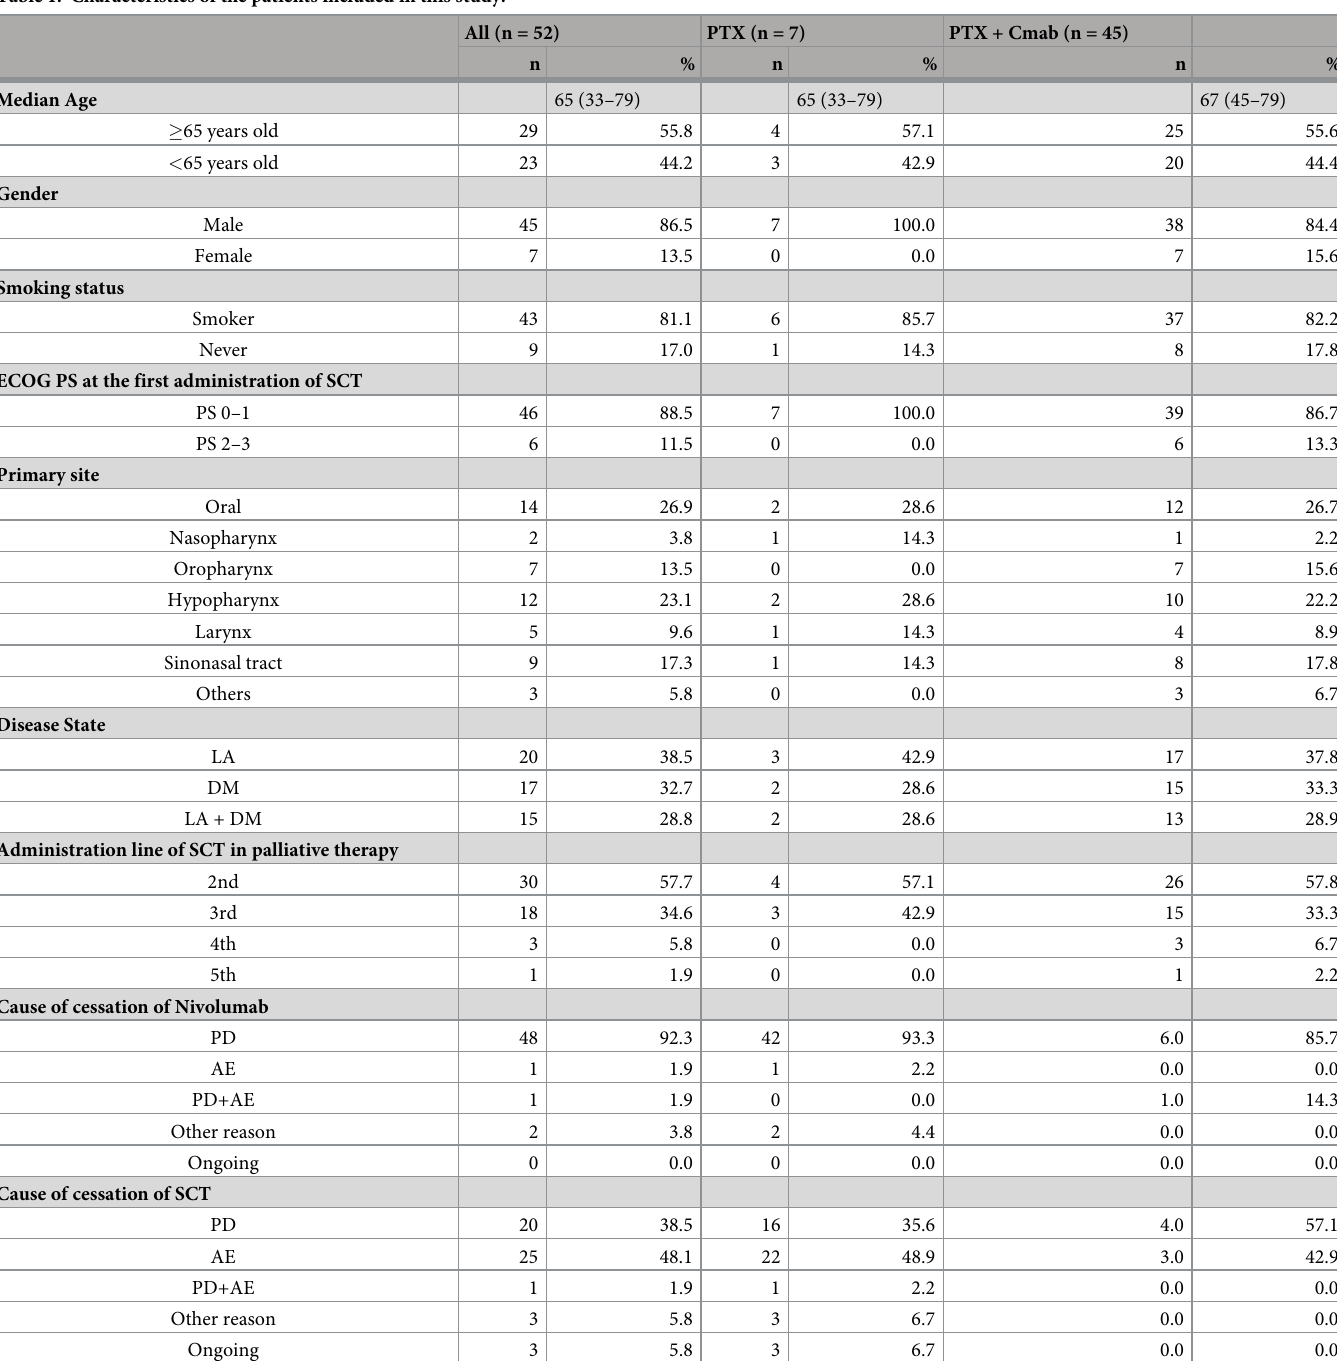
Table 1. Characteristics of the patients included in this